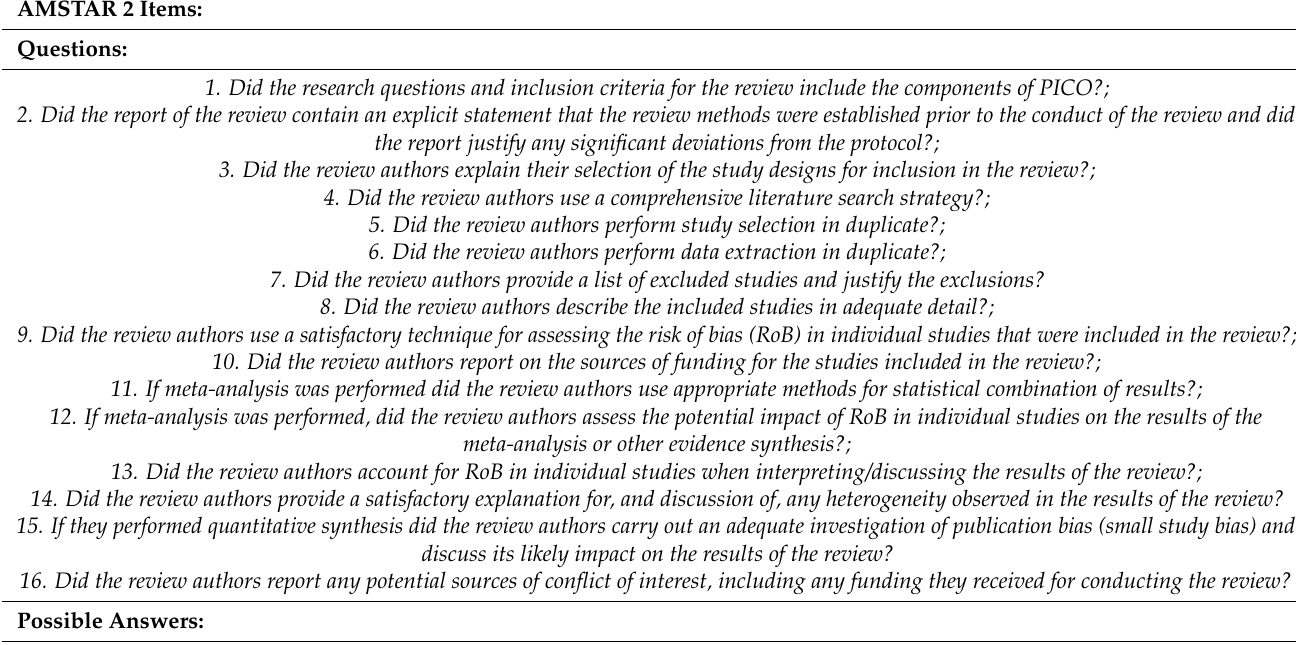
Table A3. The AMSTAR 2 assessment tool of the methodological quality of evidence reviews items and ratings